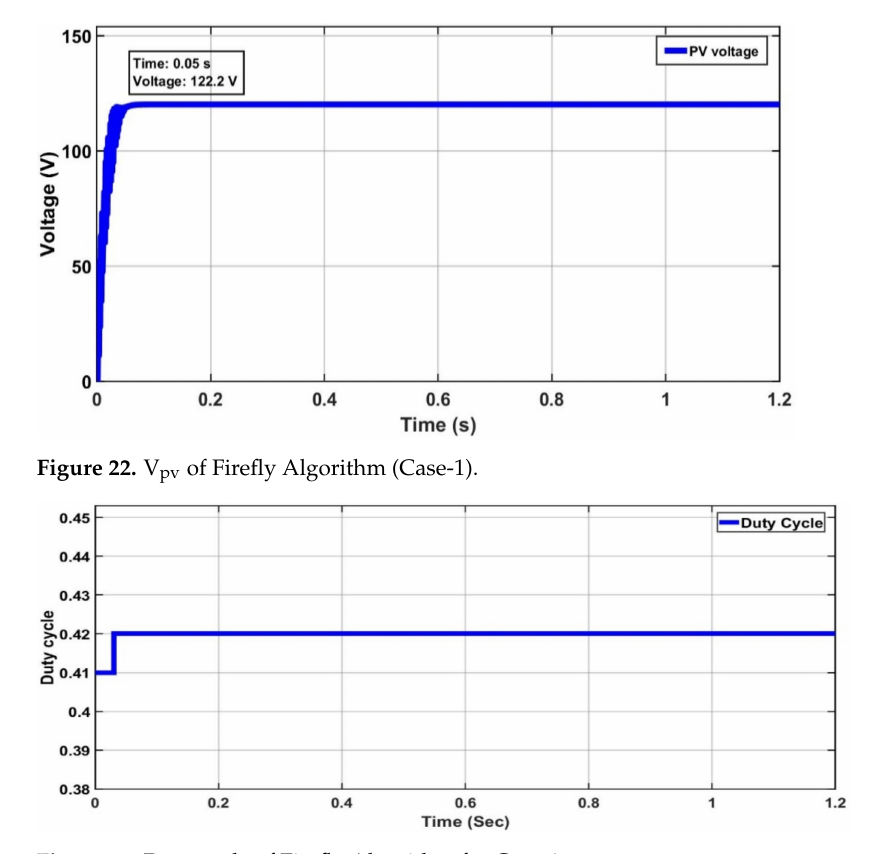
Figure 23. Duty cycle of Firefly Algorithm for Case-1.